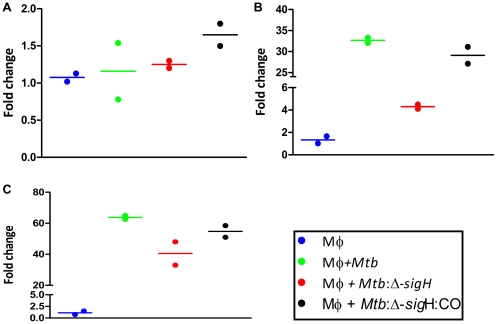
Differential expression of PTGS2 in Rh-BMDMs infected with Mtb, relative to those infected with the Mtb: Δ-sigH mutant.The expression of this gene is shown for 0, 4 and 24 hrs from either uninfected Rh-BMDMs (black open boxes), or cells infected with either Mtb (green open boxes) or the mutant (red open boxes). Results are representative of two independent experiments.